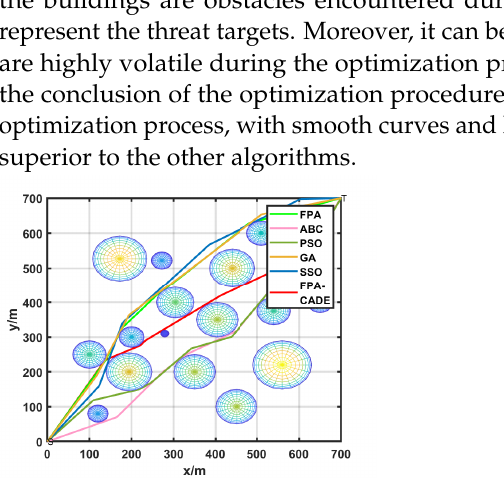
Figure 7. Mobile robot path planning route of two